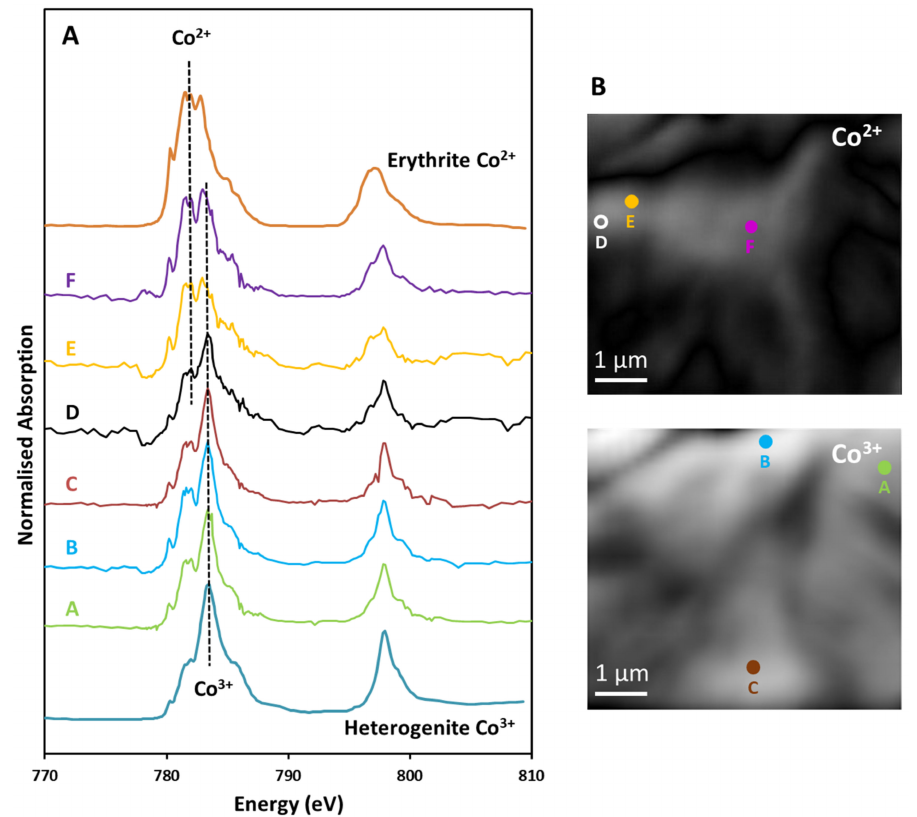
Figure 17. ( A ) L 2,3 XANES spectra for Co extracted from STXM image stacks. The positions of the absorption maxima associated with Co 2+ and Co 3+ are indicated on the spectra plot. ( B ) Oxidation state images showing the distribution of Co 2+ ( top ) and Co 3+ ( bottom ) within the Mn oxy-hydroxide grain from sample F033. The points from which the spectra have been extracted are shown on the oxidation state images.